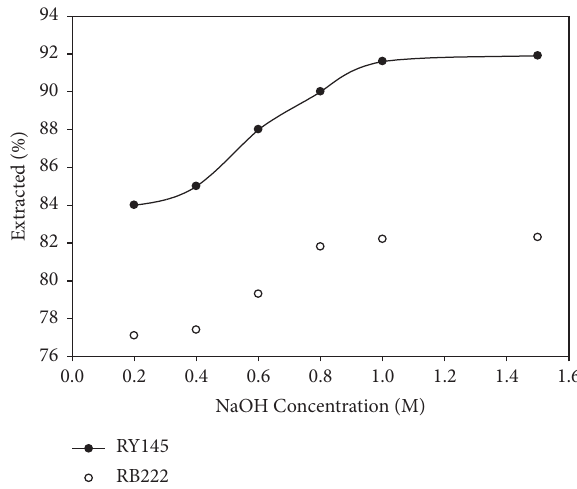
Figure 20: Effect of the concentration of stripping agent (at op- timum conditions, initial dye concentration 6 × 10 − 5 mol/10ml, solution pH 7.2 at 25 ° C).